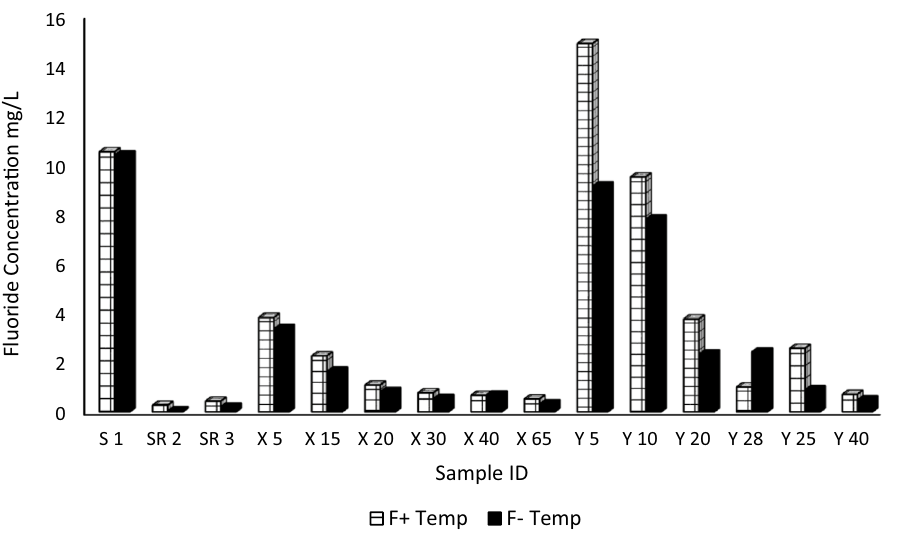
Figure 10. Fluoride leachate behaviour at room temperature and at 40 °C, F + Temp = Fluoride concentration at induced temperature and F-Temp = fluoride at concentration at room